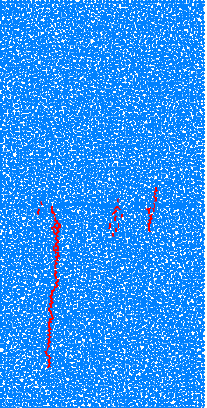
Figure 7. Photographs of specimens showing fractures propagating upward and downwards from a persistent horizontal joint.